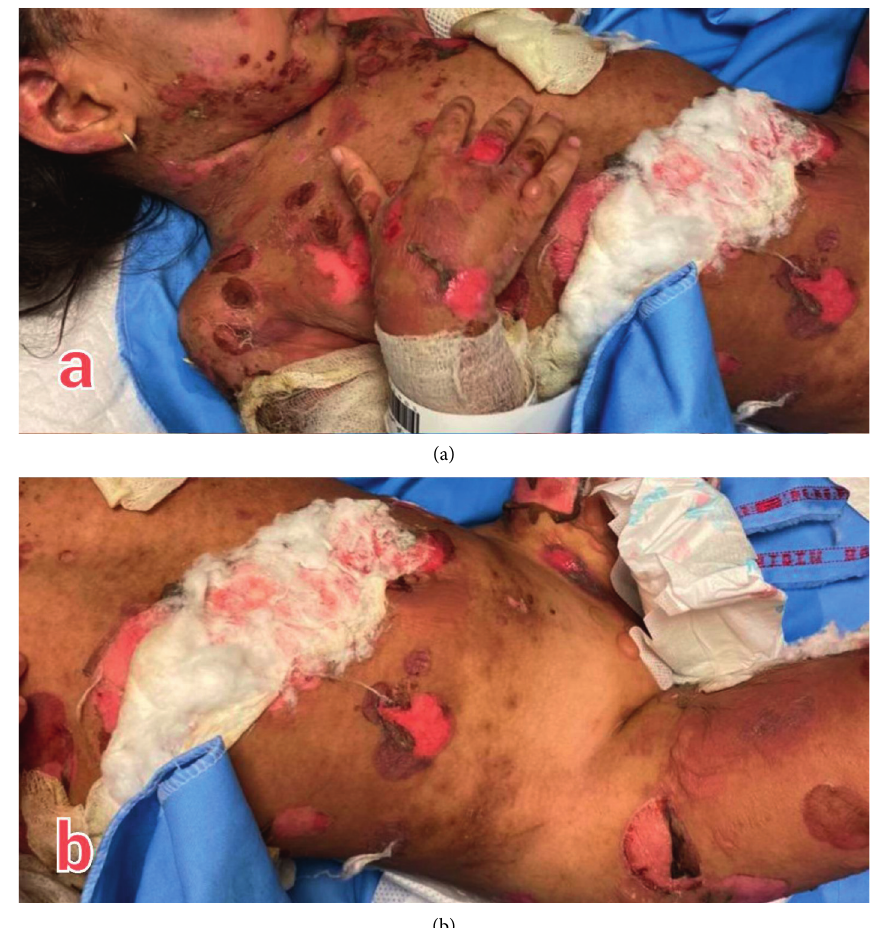
Figure 1: Generalized erosions and flaccid bullae (a,